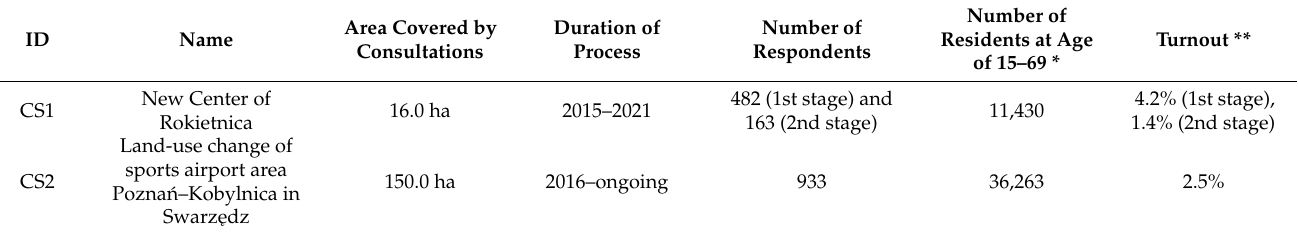
Table 2. Characteristics of the analyzed applications of PPGIS tools.